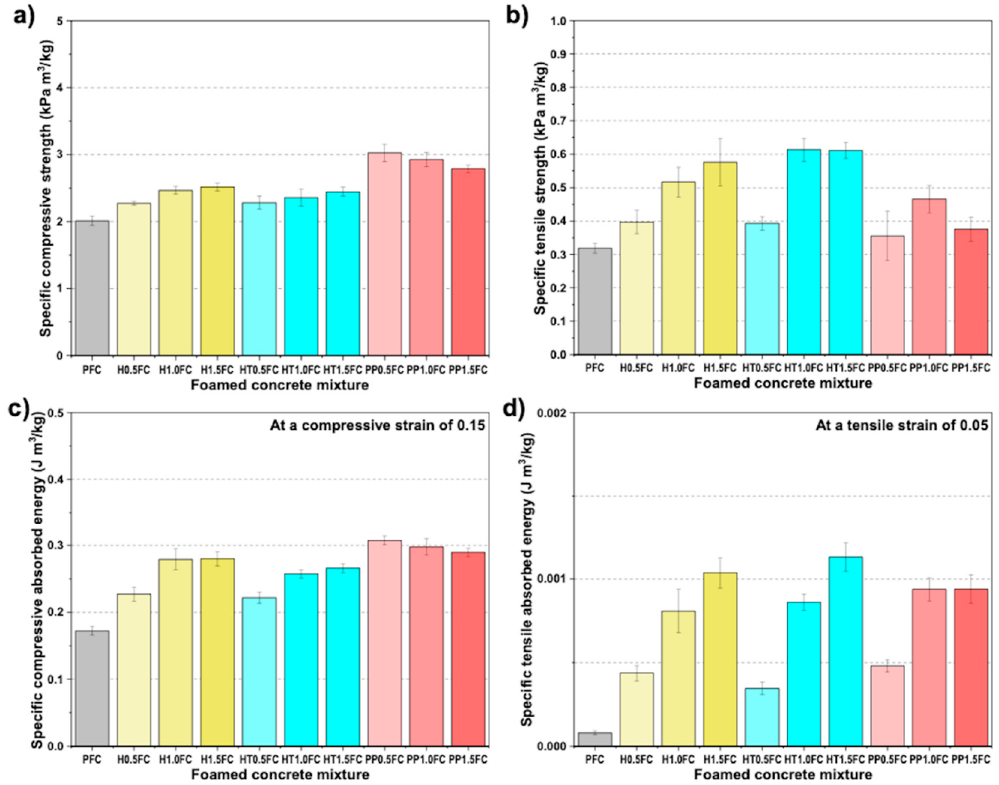
Figure 9. Normalized mechanical properties of foamed concrete mixtures: ( a ) specific compressive strength (SCS); ( b ) specific tensile strength (STS); ( c ) specific compressive absorbed energy (SCAE) and ( d ) specific tensile absorbed energy (STAE).